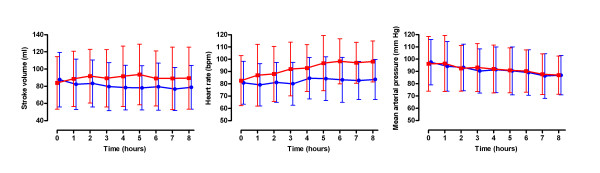
Haemodynamic data for goal directed therapy and control groups during the intervention period. Significant differences between groups: heart rate, stroke volume (both p < 0.0001, repeated measures ANOVA) but not mean arterial pressure (p = 0.87). Red squares: GDT group, Blue circles: control group. Data presented as mean (SD).